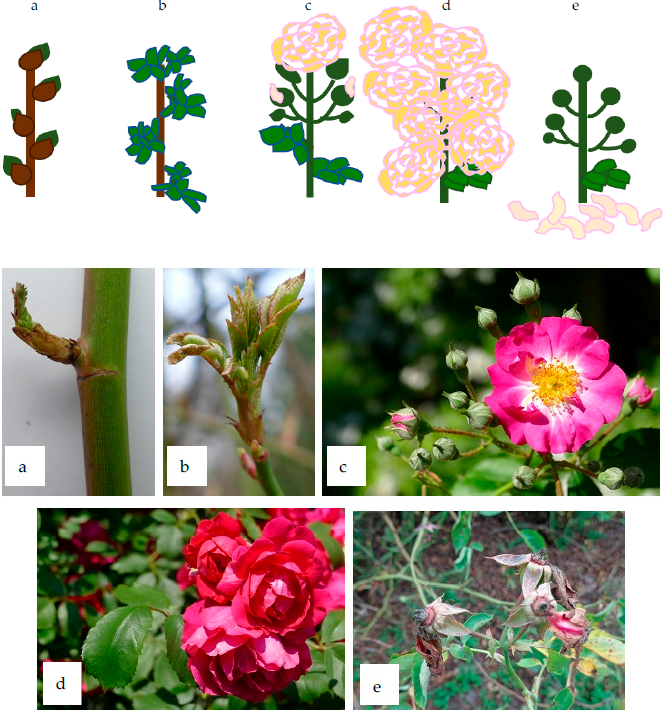
Figure 1. The chosen phenology stages on a scale 0–5 in climber roses, where: ( a ) BBCH 07—starting of bud break, first leaf tips appears; ( b ) BBCH 11—the first light green and/or bronze leaves pair develops, not yet at full size; ( c ) BBCH 60,601—start of flowering (about 10% of flowers open); ( d ) BBCH 63,605—full of flowering (at least 50% of flowers open); ( e ) BBCH 69,609—end of flowering (after all petals shedding).